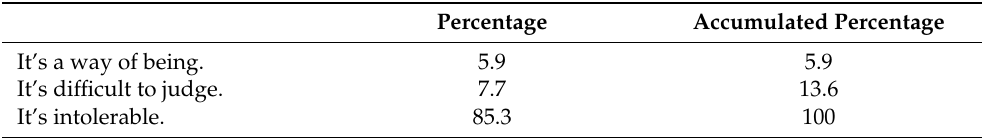
Table 5. Judgment distribution toward discrimination against women.